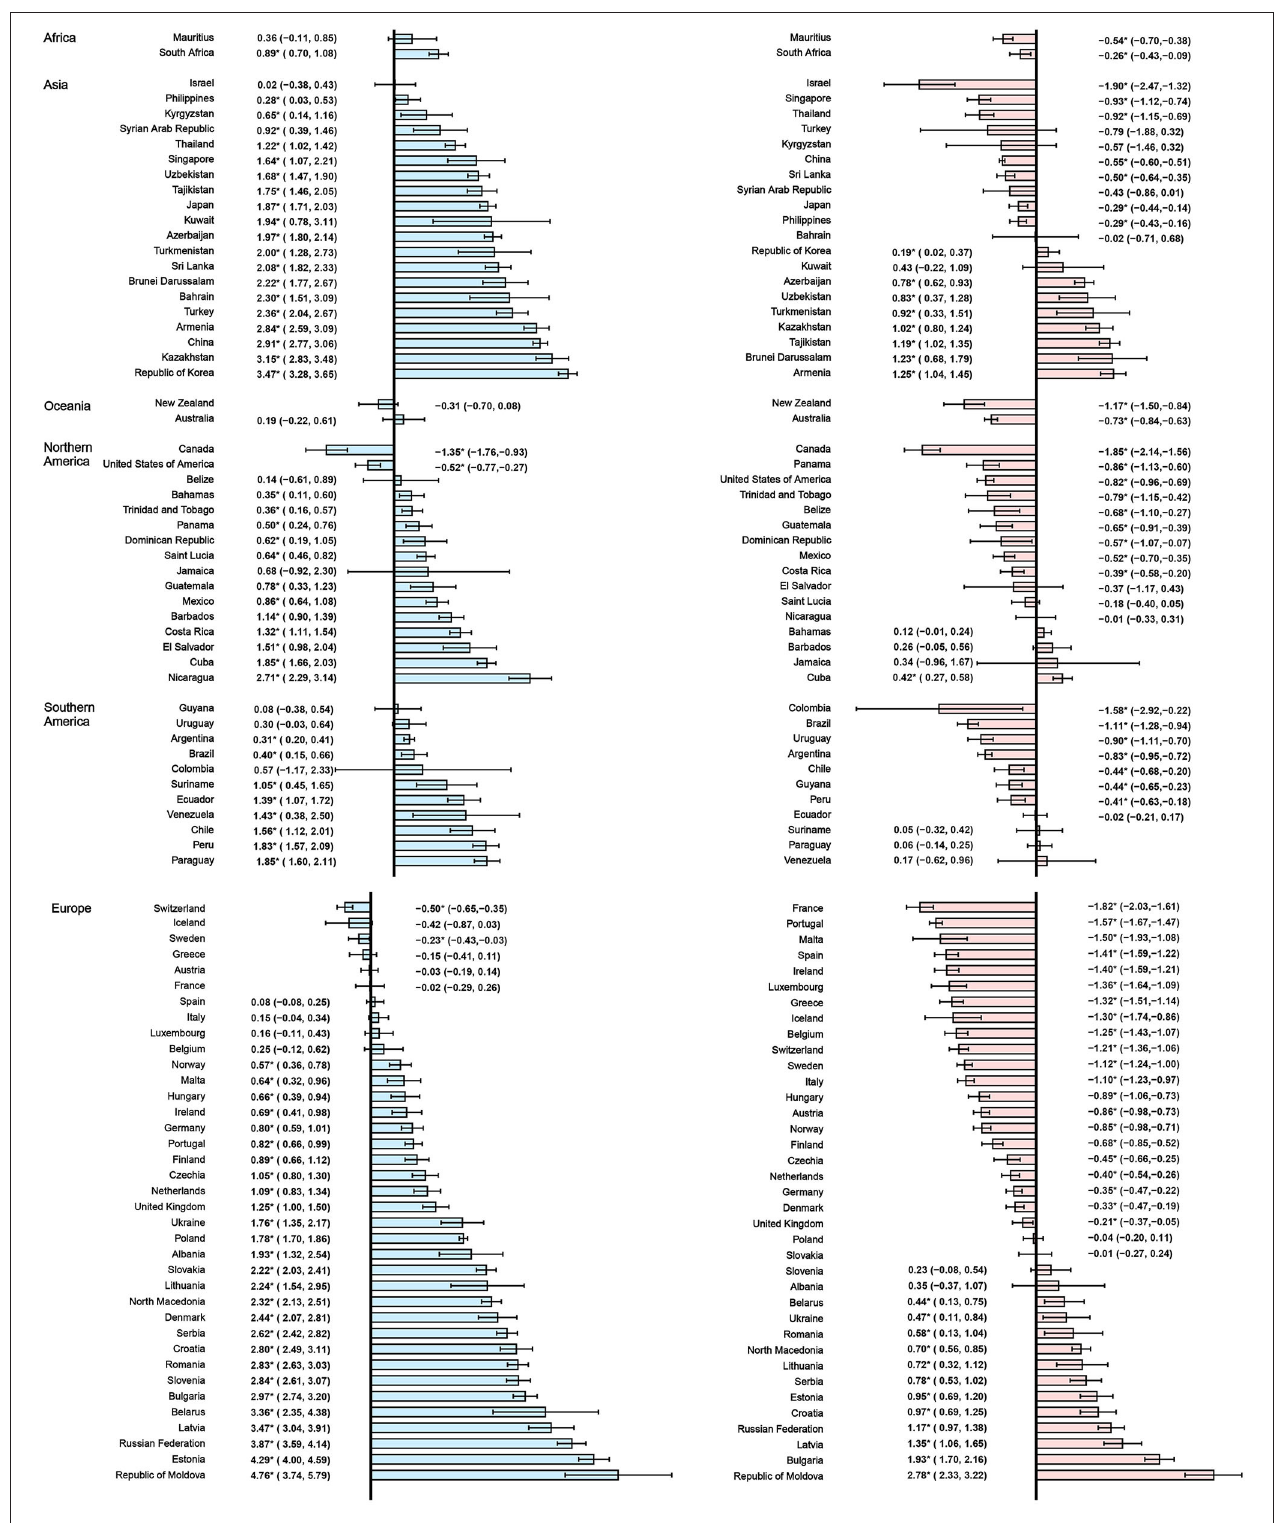
FIGURE 3 | The AAPC of the ASIR (blue bars) and ASMR (red bars) of prostate cancer. * P < 0.05. AAPC, Average annual percent change; ASIR, age-standardized incidence rate; ASMR, age-standardized mortality rate.